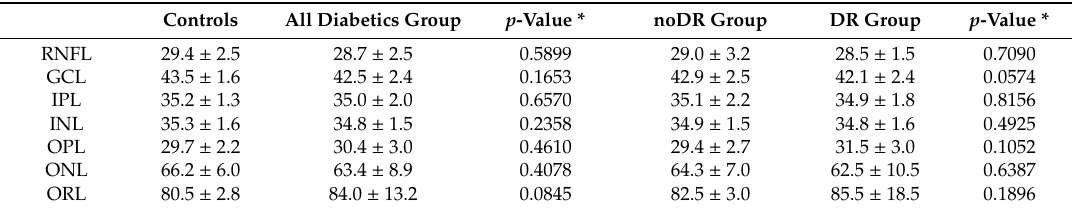
Table 2. Retinal layers thickness in the Early Treatment Diabetic Retinopathy Study (ETDRS) map (6 mm